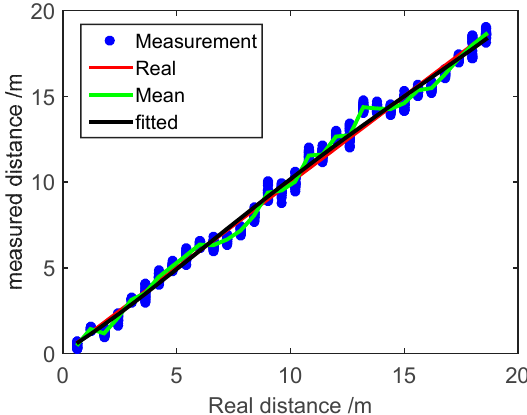
Figure 4. Measured distance values after the LSR correction.